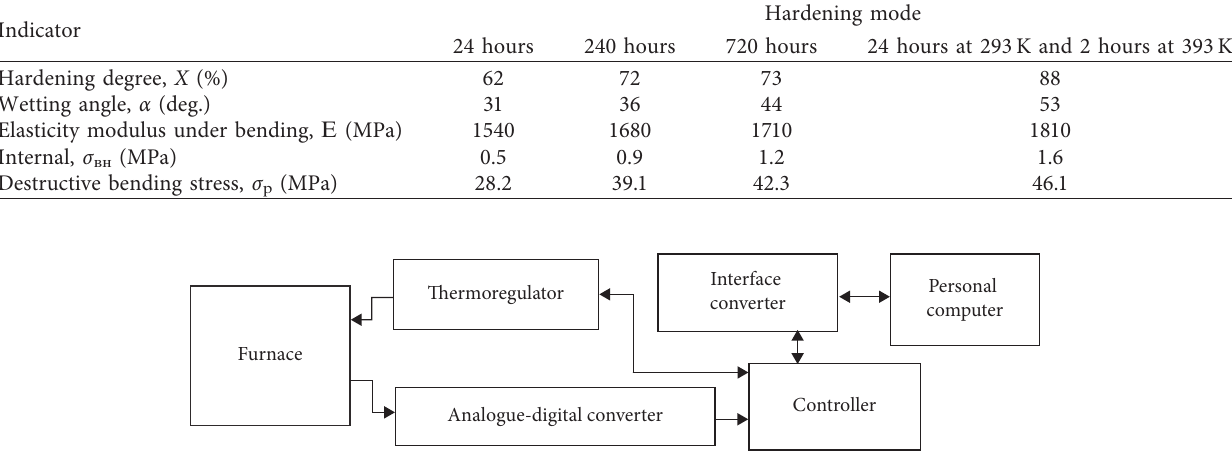
Figure 1: Block diagram of automated control of the heat treatment process.